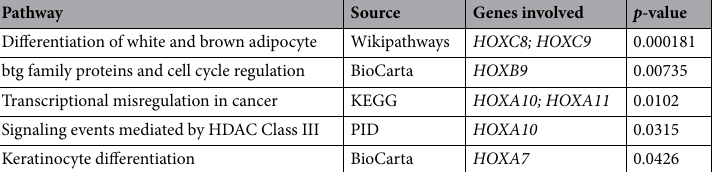
Pathway Source Genes involved p -value Differentiation of white and brown